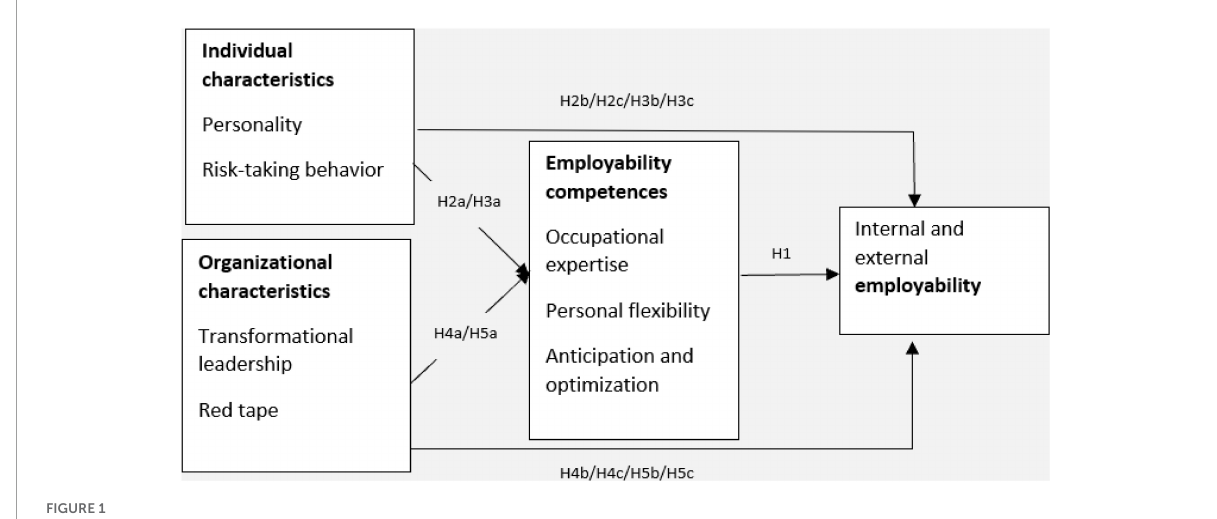
FIGURE1 Research